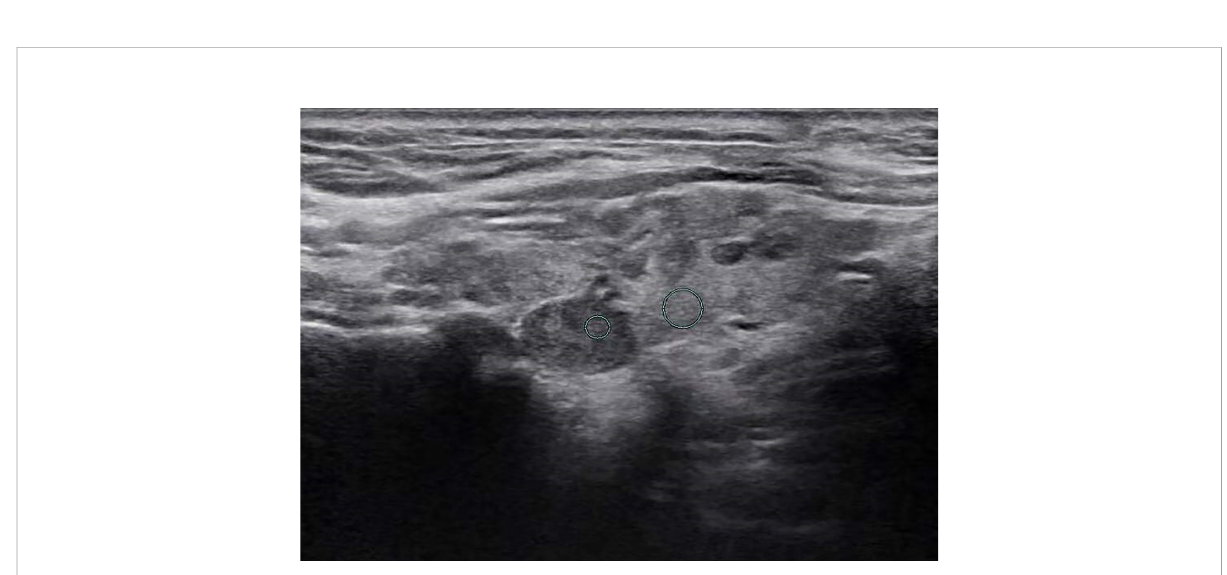
FIGURE 4 Female patient, 60 years old, 5-year case history of a thyroid nodule, pathology con fi rmed as adenomatous goiter with HT. TPO-Ab = 28.3 kU/ L, TG-Ab>500 kU/L, UGSR = 78.73/105.3 = 0.7477 (medical center A).